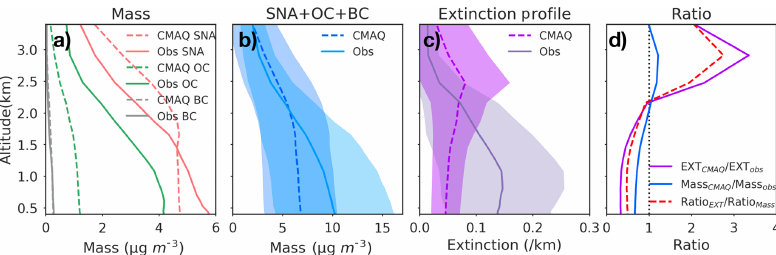
Figure 7. Campaign-mean vertical profiles of (a) aerosol composition, (b) total mass (SNA + OC + BC), and (c) extinction from CMAQ vs. observations from the DISCOVER-AQ 2011 Baltimore–Washington, D.C. campaign. (d) Campaign-mean vertical profile of the model-to- observation ratio of extinction (Ratio EXT ), total aerosol mass (Ratio Mass ), and Ratio EXT / Ratio Mass . Aircraft observations are first aggregated to match model layers, and corresponding model values are sampled concurrently with the time of observations. CMAQ modeled extinction is estimated with FlexAOD using the default parameters in Table 1. The shading in (b) and (c) shows the standard deviation of the day-to-day